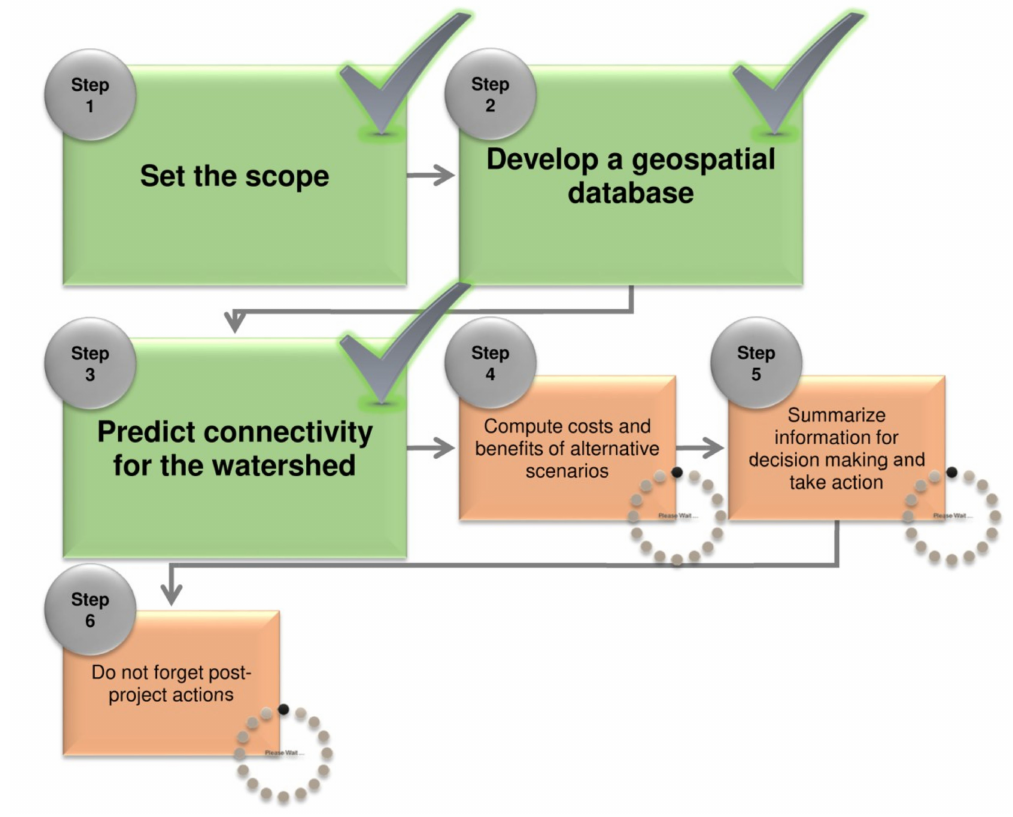
Figure 2. General workflow for prioritizing dam removal. Steps 1–3 are addressed in this study, while steps 4–6 correspond to ongoing